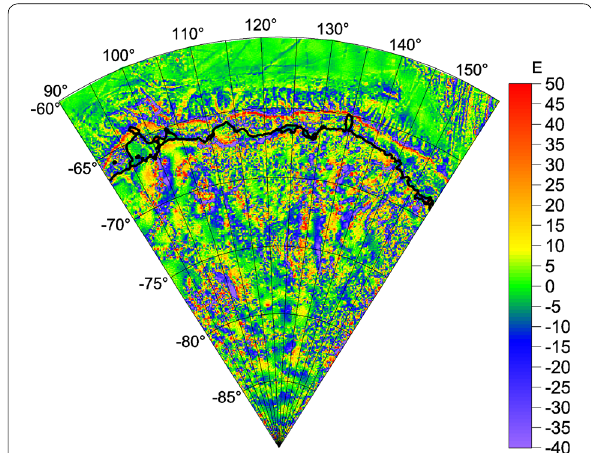
Fig. 7 T zz [E] in the Wilkes Land anomaly area, using the RET 14 model